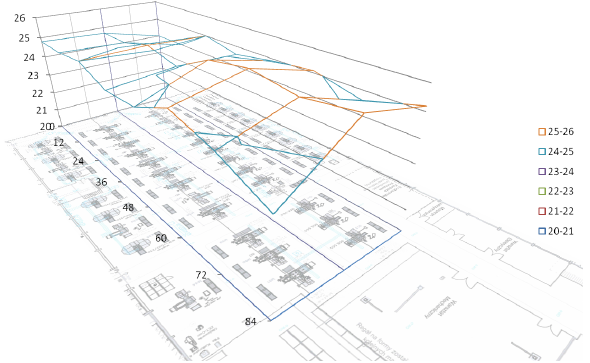
Figure 2: Air temperature in Hall1 at a height of 2 m, °C.